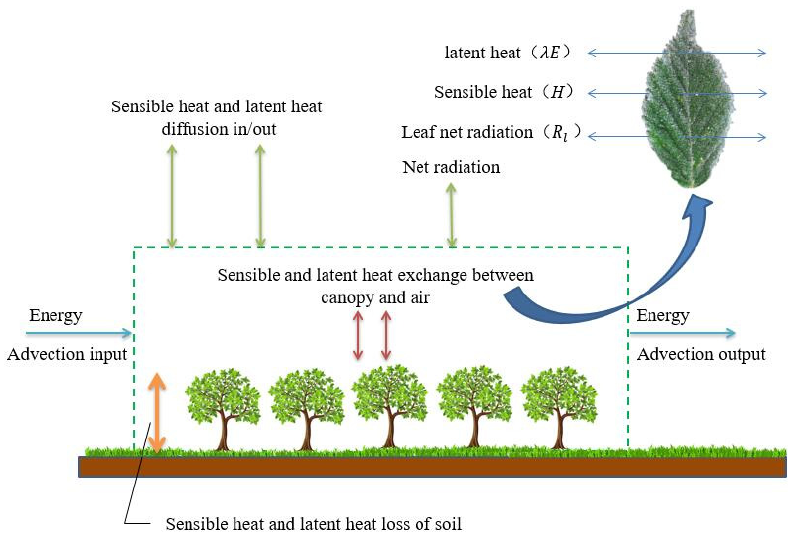
Figure 3. Schematic diagram of energy exchange at the plant canopy under frost conditions.